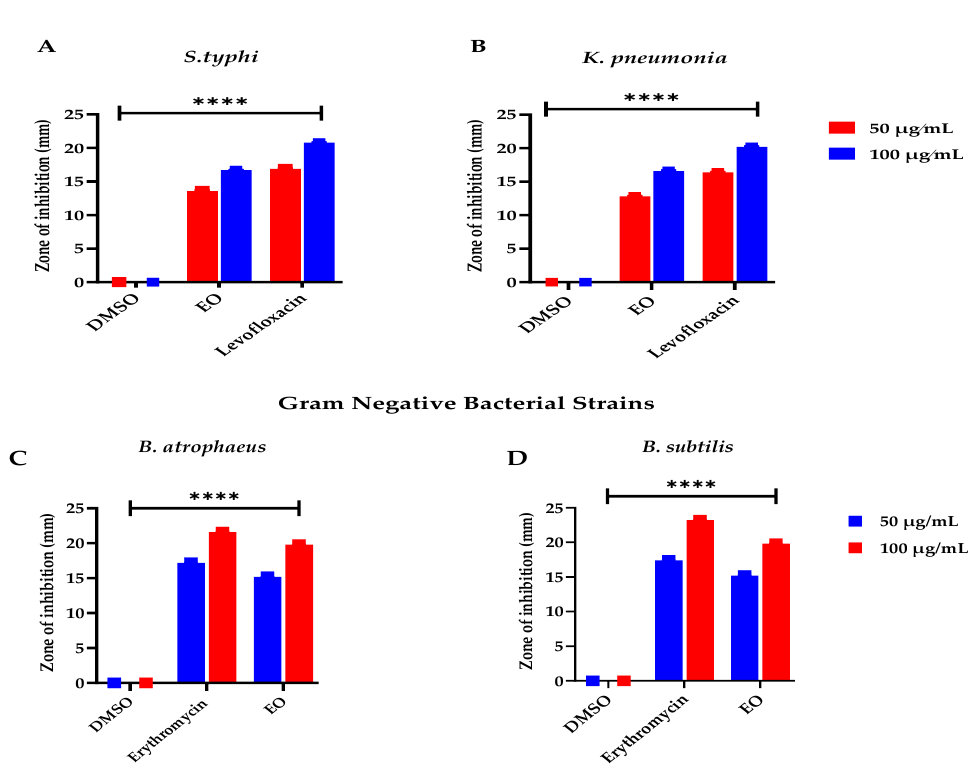
Figure 3. Antibacterial potential of ELEO. levofloxacin and erythromycin were used as standards against the gram-negative and gram-positive bacterial strains, respectively, whereas the DMSO was used as a negative control. ( A ) represents bacterial resistance against S. typhi, ( B ) K. pneumonia , ( C ) B. atrophaeus , and ( D ) B. subtilis . All the data was taken in triplicate ( n = 3) and analyzed through two-way ANOVA, via Tukey’s multiple comparison test, ns = >0.9999, p = **** <0.0001.